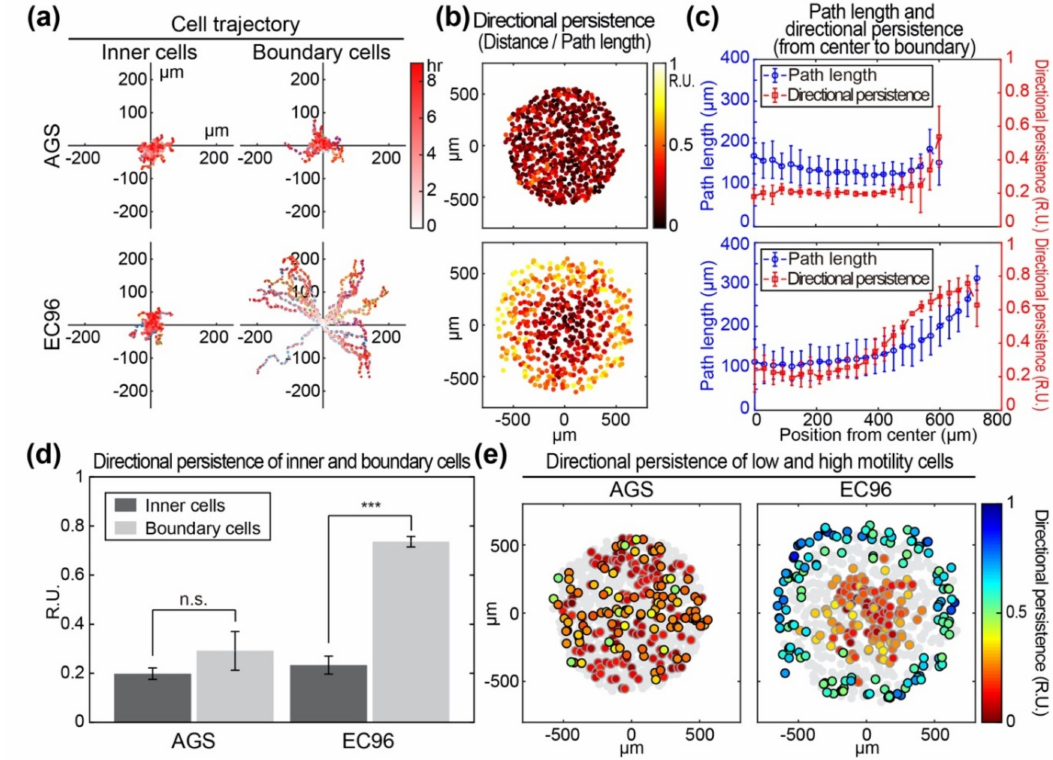
Figure 2. Comparison of motility and directionality of AGS and EC96 cell islands. ( a ) The trajectory from the initial locations of the inner and boundary cells within the AGS and EC96 cell islands. The stronger red color of the dots indicates more time passed. ( b ) Color-code map of the directional persistence of the cells within the AGS and EC96 cell islands. The brighter